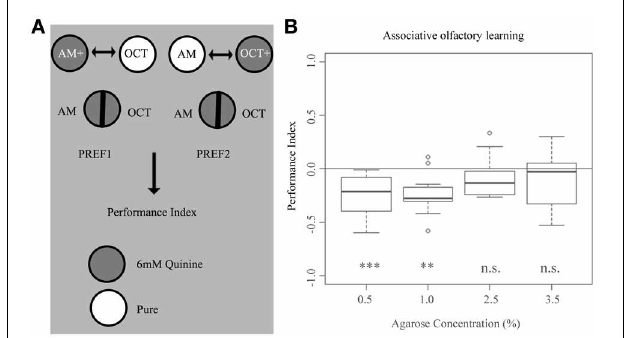
FIGURE 6 | Larval associative olfactory learning reinforced by 6mM quinine depends on the concentration of the agarose substrate. (A) Overview of the experimental setup to test for larval associative olfactory learning reinforced by 6mM quinine. (B) Wild-type larvae show different odor-quinine learning for agarose concentrations of 0.5, 1.0, 2.5, and 3.5%. Only at agarose concentrations of 0.5% and 1.0%, odor-quinine learning leads to the expression of the association ( p < 0 . 001 for 0.5% agarose and p < 0 . 01 for 1.0% agarose if tested against zero). No significant learning is detectable when increasing agarose concentration to 2.5 or 3.5% (for both cases p > 0 . 05 if tested against zero). A significant difference for each group against random distribution is shown below each box-plot. Sample size n > 12 for each group. Small circles indicate outliers. ∗∗∗ p < 0 . 001; ∗∗ p < 0 . 01; n.s., not